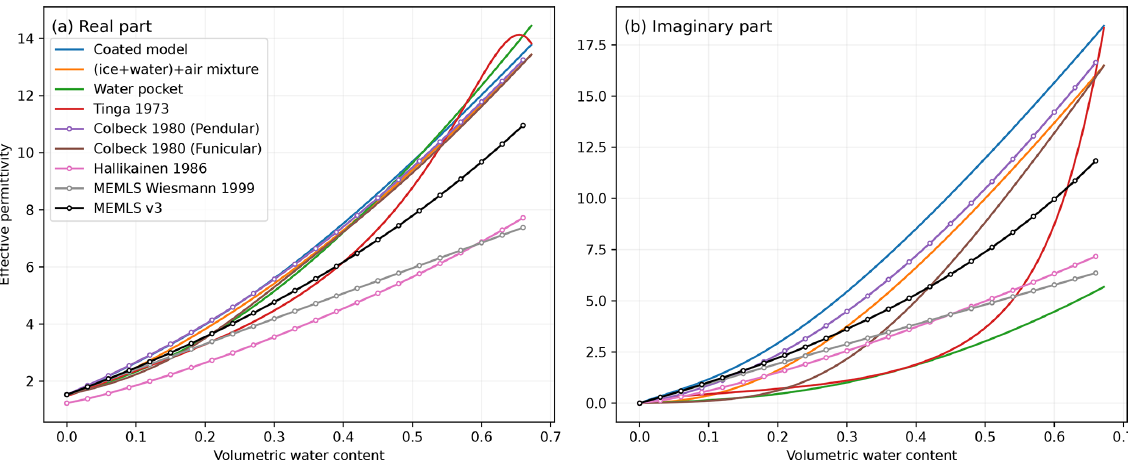
Figure 2. Real (a) and imaginary (b) parts of wet snow effective permittivity at 19GHz, calculated with different formulations for increasing quantities of water filling the pore space of snow with an initial density of 300kgm − 3 up to the saturation point (i.e., until no air is left in the